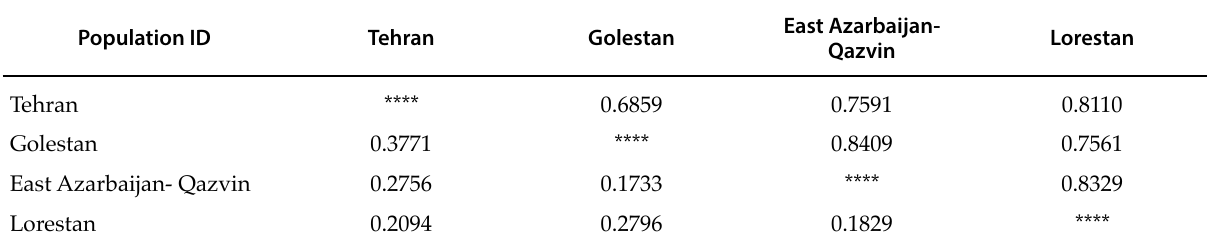
Table 5. Neiʼs original measures of genetic identity (above diagonal) and genetic distance (below diagonal) between popu - lations (Nei,